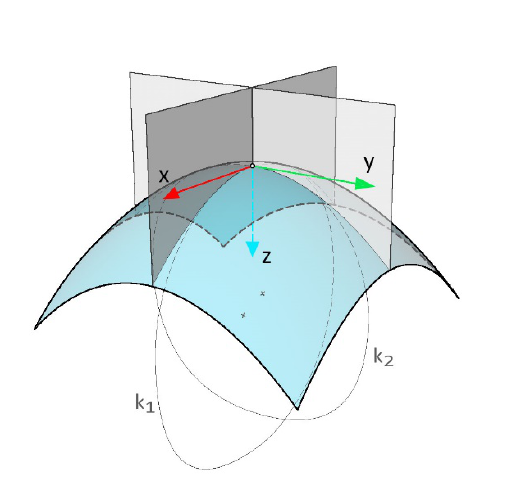
Fig. 4 Principle of Gaussian Curvatures.